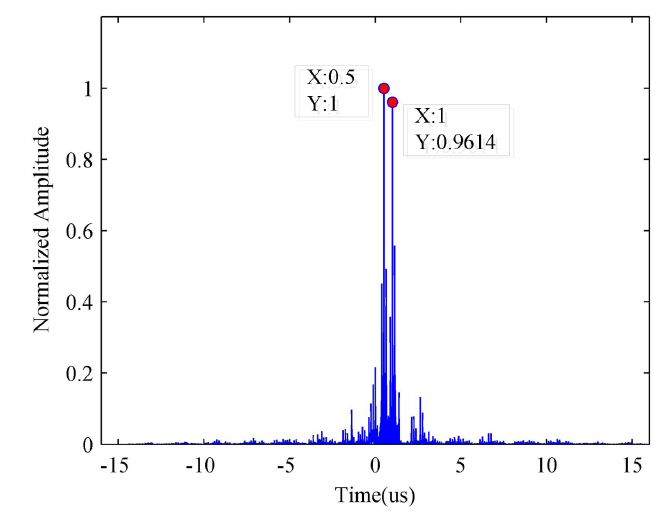
Figure 10. The cross-correlation result of the reconstructed sampled signal ˆ x s ( t ) and radar echo signal x r ( t )